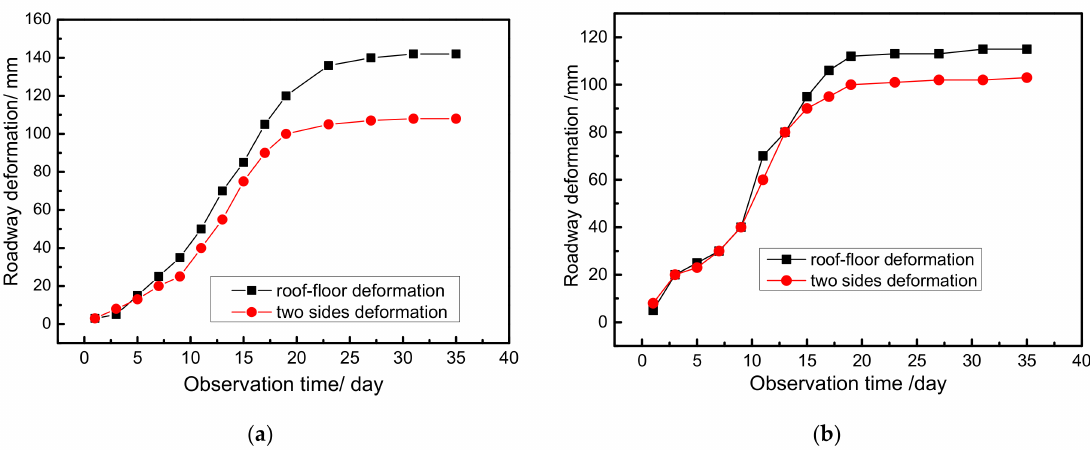
Figure 16. Deformation of the test roadway surrounding rock.